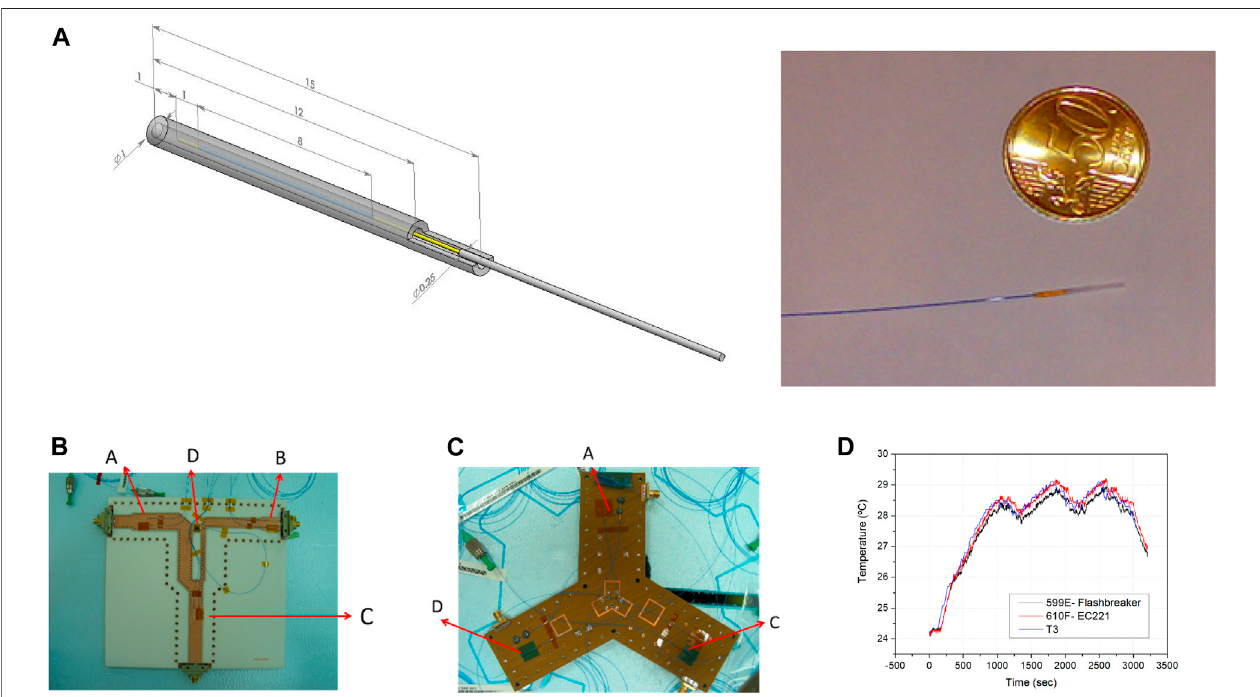
FIGURE 3 | (A) Terminal temperature sensor design and picture by HBM, (B) 17 FBG sensors (HBM FiberSensing design) placed on inner layers and surface on a Wilkinson divider from GALILEO ’ s NAVANT antenna, (C) 9 FBG sensors placed on inner layers and surface on a Mars ROVER divider sample, (D) comparative results between FBGs and thermocouples on the Wilkinson